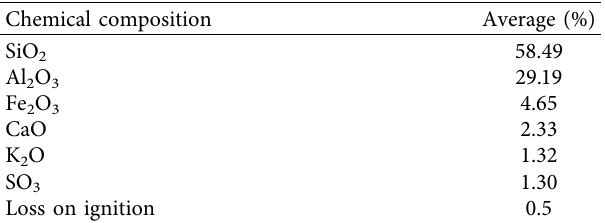
Table 2: Chemical composition of fly ash. Chemical